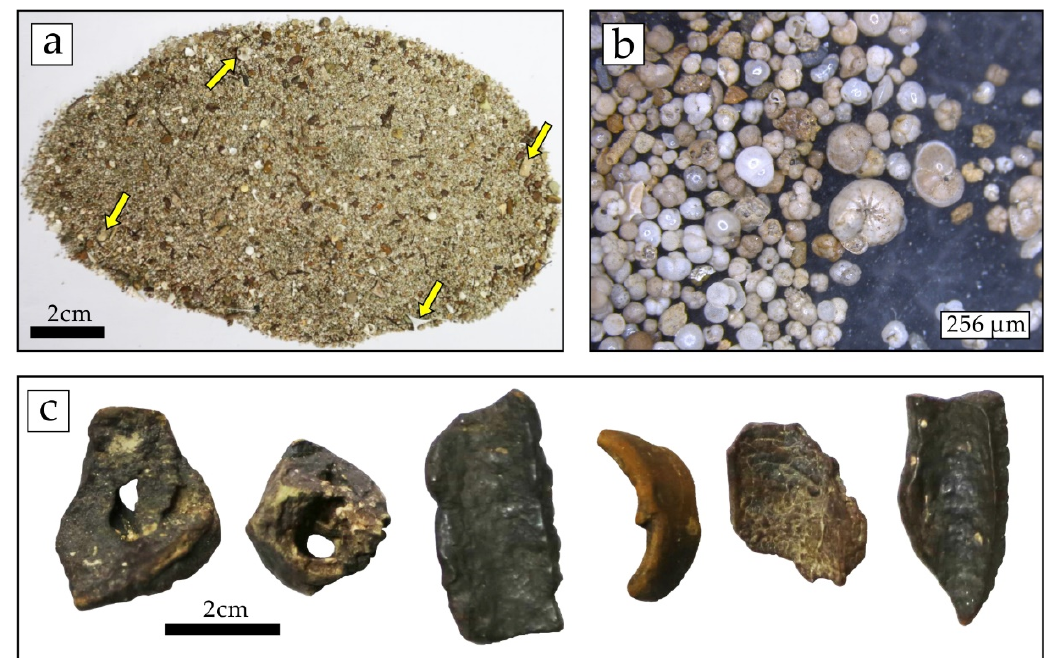
Figure 3. Samples collected from the study area. ( a ) Surface sediment sampled along with tubular carbonate fragments on the seafloor. Note the abundant small carbonates and bioskeletal fragments (yellow arrows). ( b ) Sediment rich in foraminifera. ( c ) Fragments of tubular carbonates. Note the extensive coatings of iron and manganese hydrous oxides on the surface of the